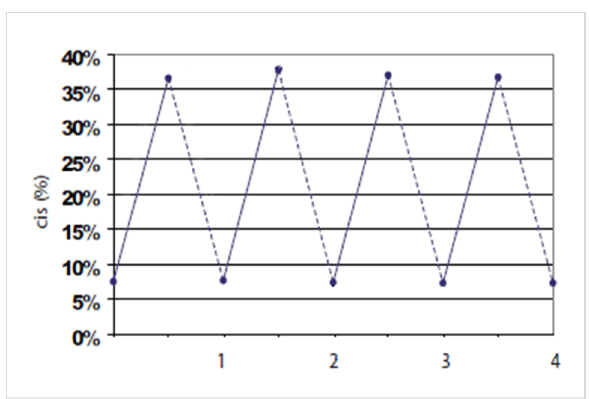
Figure 3: Percentage of cis isomer of AZO-CDim 1 produced during photoisomerization cycles ( c = 10 − 4 M, water). A cycle consists of ir- radiation at 365 nm for 2 h followed by irradiation at 254 nm for 1